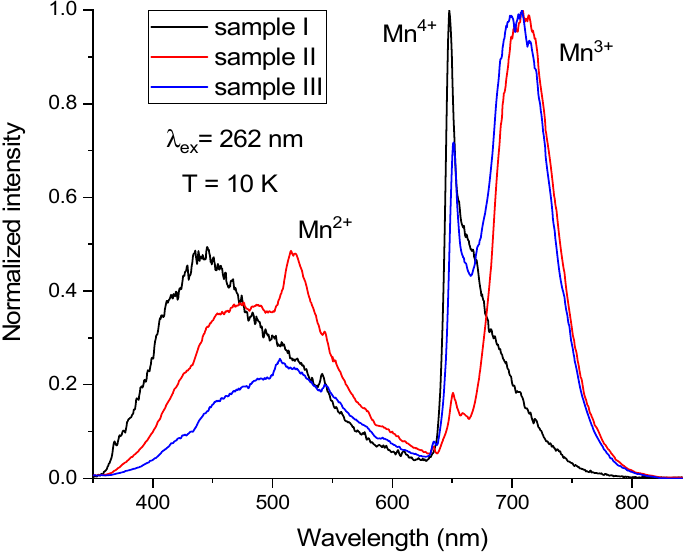
Figure 9. Normalized PL spectra of samples I, II, and III measured at 10